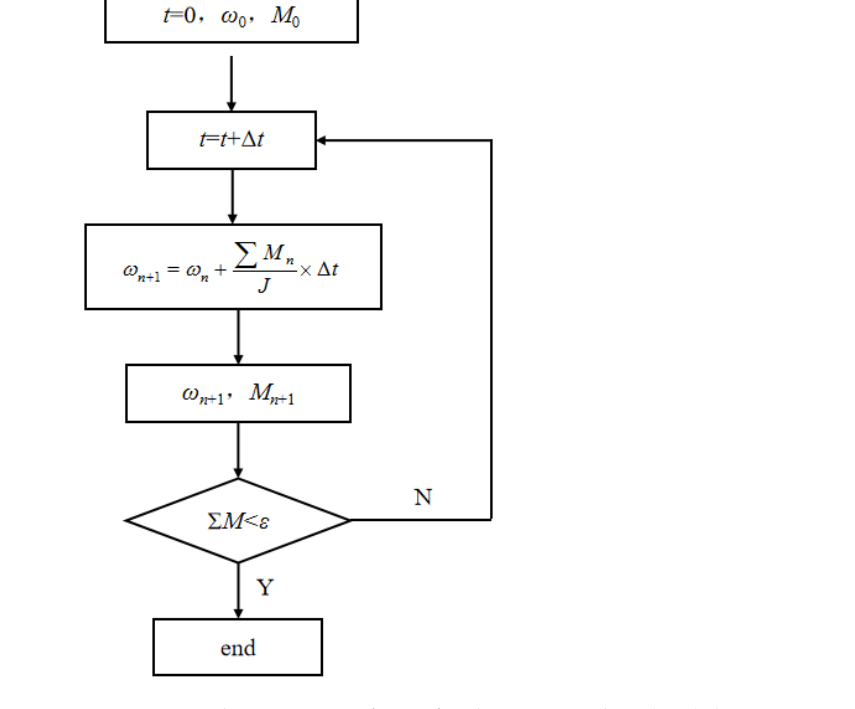
Figure 1. Simulation process of centrifugal pump as turbine (PAT) during starting period (Δ t = 0.0005 s).